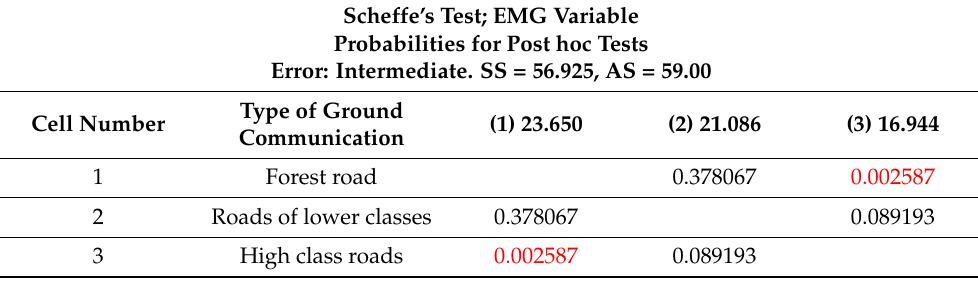
Table 9. Post hoc test to analyze the variance of muscle load values depending on the type of com- munication when driving the passenger car. The gray text indicates statistical significance.